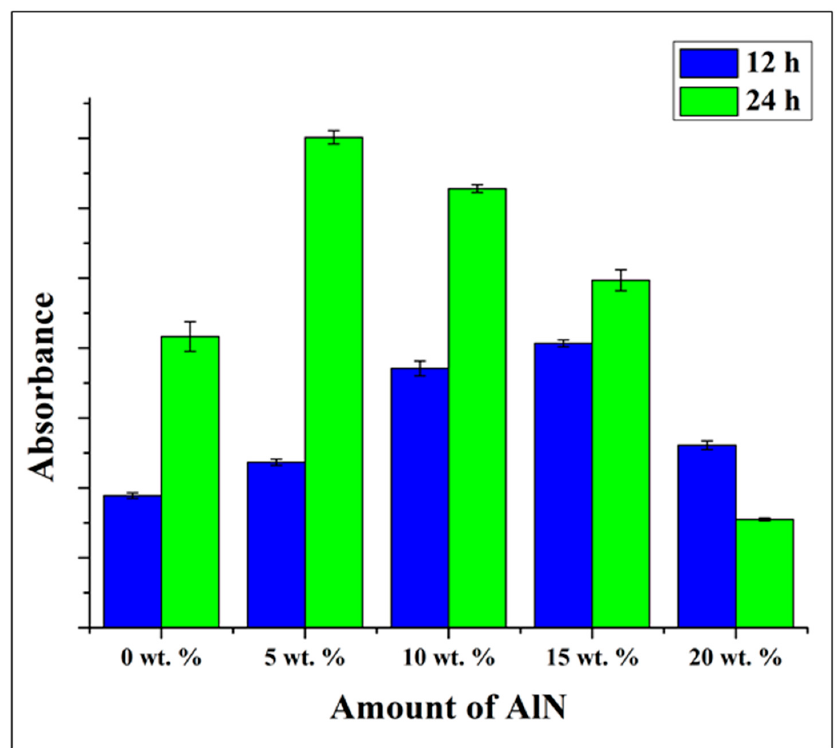
Figure 9. WST adsorption after 12 and 24 h of testing with Staphylococcus epidermidis on the CA/AlN composites, as a function of the fraction of AlN.